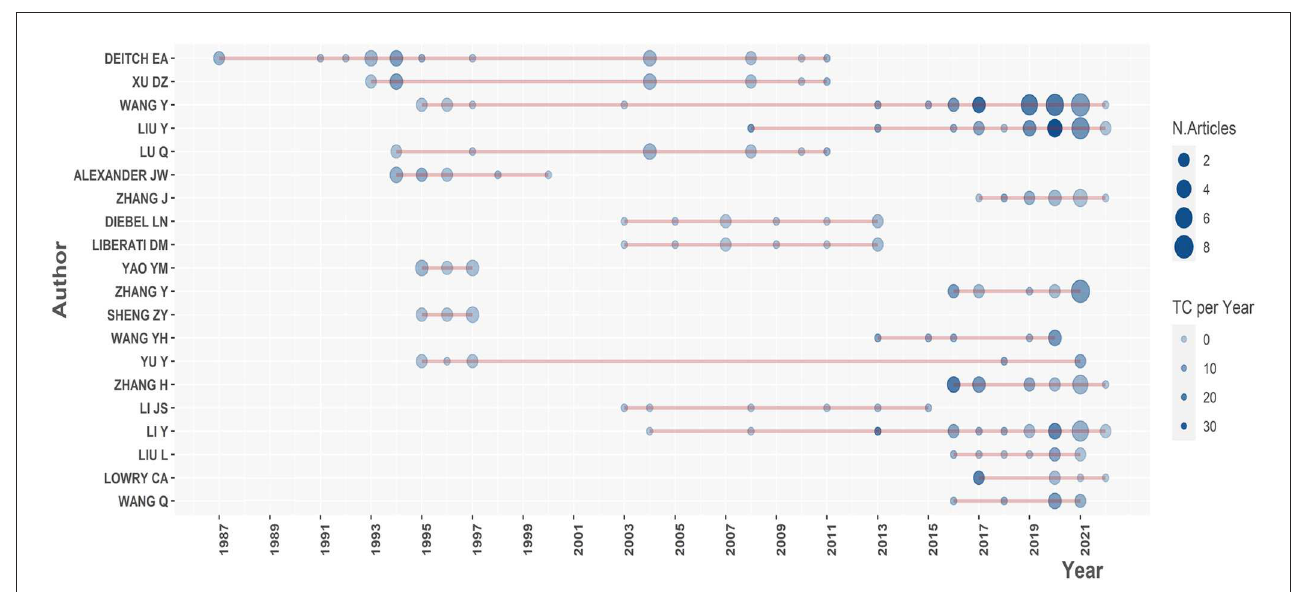
FIGURE6 Production of the top 20 productive authors over time in gut microbiota and trauma research.